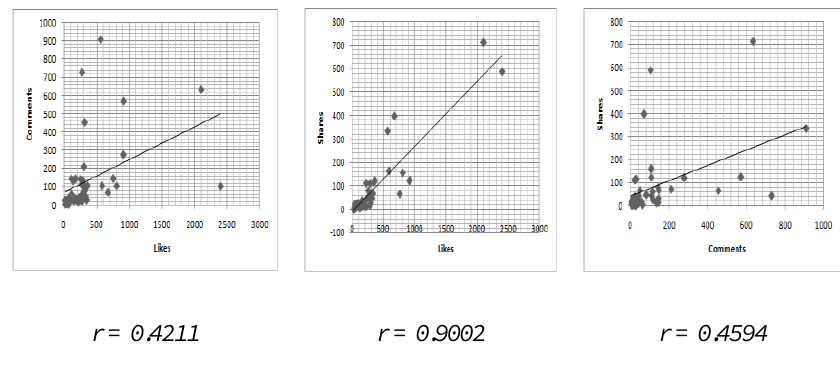
Fig. 13. Correlation Results for Page